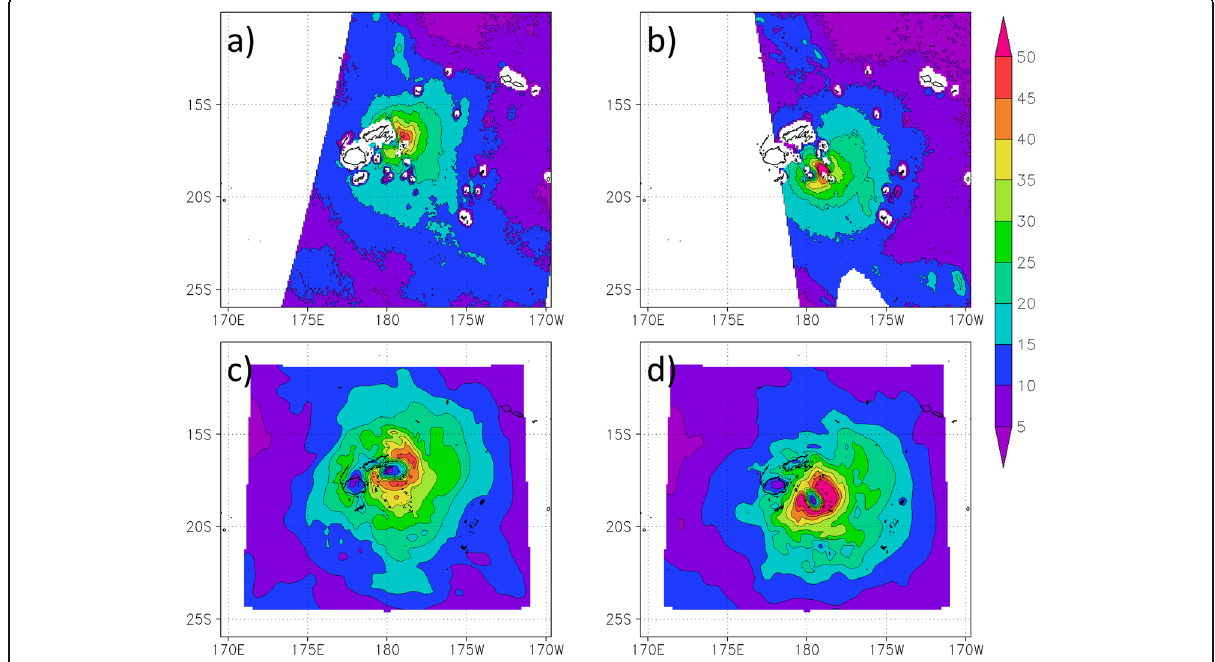
Fig. 6 Comparison of the wind speed around the Fiji Islands. a AMSR-E sea surface wind at 14 UTC on 15 March, b AMSR-E sea surface wind at 02 UTC on 16 March, c WRF 10 m wind speed at 14 UTC on 15 March, and d WRF 10 m wind speed at 02 UTC on 16 March. The unit of the color bar is